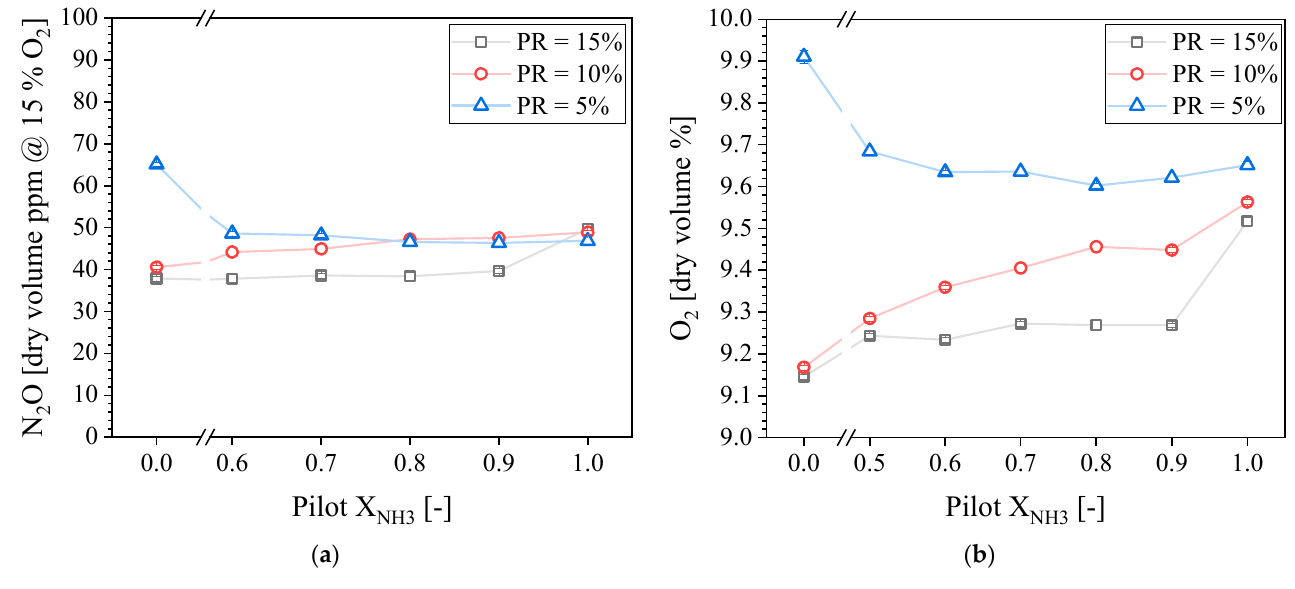
Figure 13. Measured N 2 O ( a ) and O 2 ( b ) concentration in the exhaust gases as a function of the pilot NH 3 for different PRs.